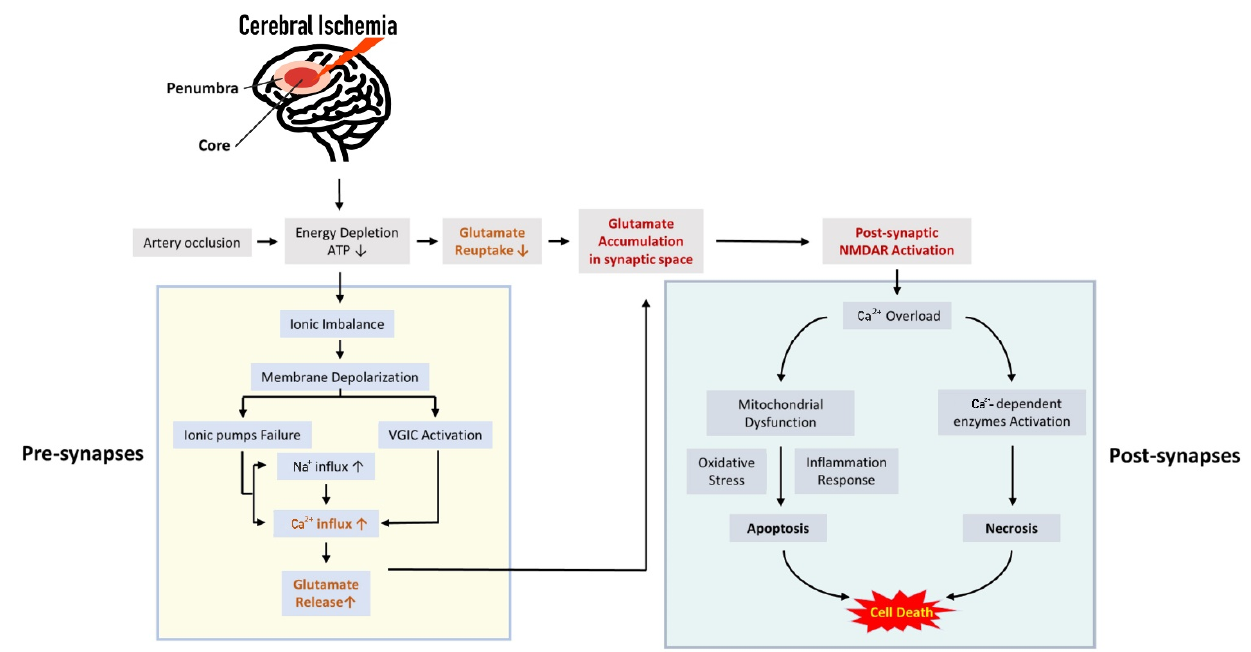
Figure 1. Cascade reaction process of glutamatergic neurotransmission in cerebral ischemia. The depolarization of neuronal membrane potential mediated by ion imbalance after cerebral ischemia can activate glutamatergic synapses, causing excessive glutamate release and production of neurotoxicity, which thereby disrupts the normal physiological structure of synapses resulting in its functional collapse. This is also considered the initial event leading to the signal cascade reaction. Subsequently, the receptor represented by NMDAR mediates the processes of cellular calcium overload, mitochondrial damage, oxidative stress, and inflammatory responses, accelerating severe delayed brain injury and neuronal necrosis (the vertical arrow in the rectangular frame indicates the up-regulation or down-regulation of corresponding pathological events).